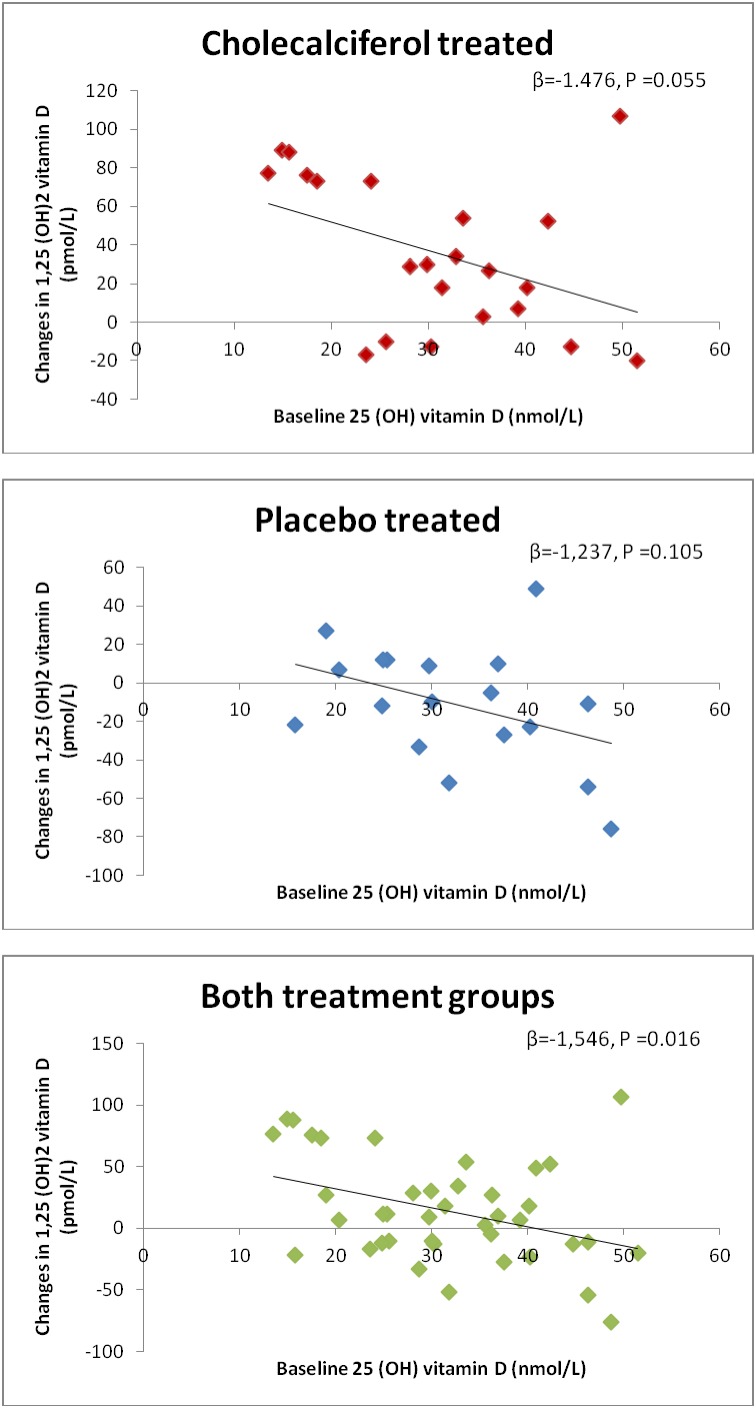
Changes in 1,25(OH)2vitamin D according to baseline level of 25(OH)vitamin D in the cholecalciferol group, the placebo group and both treatment groups.Changes in 1,25(OH)2vitamin D are depending on the baseline level of 25(OH)vitamin D β = linear regression coefficient.